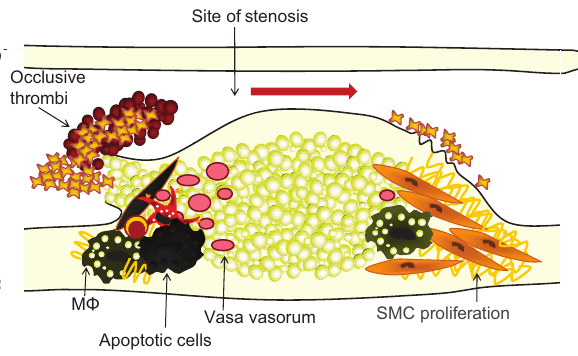
Figure 1 The possible targets for the nanomedical approaches to the treatment of the advanced atherosclerotic plaques. The sche- matic presentation of the longitudinal section of a vessel-narrowing atherosclerotic lesion based on the histologic observations. The block arrow indicates the blood flow direction. M Φ , macrophage; SMC, smooth muscle